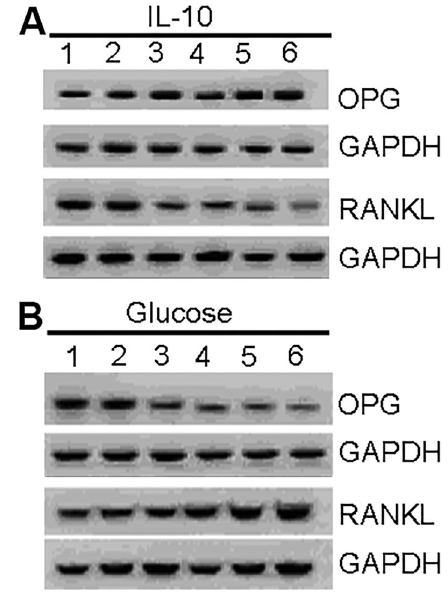
Figure 3. Effects of IL-10 ( A ) and glucose ( B ) at different concentrations on the protein expression of osteoprotegerin (OPG) and receptor activator of nuclear factor- k B ligand (RANKL) in human periodontal ligament fi broblasts. Panel A , lanes 1 – 6 : cells treated with interleukin-10 (IL-10) at 0, 1, 10, 25, 50, and 100 ng/mL, respectively. Panel B , lanes 1 – 6 : cells treated with glucose at 0, 5.5, 10, 20, 30, and 40 mmol/L, respectively. GAPDH: anti-glyceraldehyde-3-phosphate dehydrogenase.